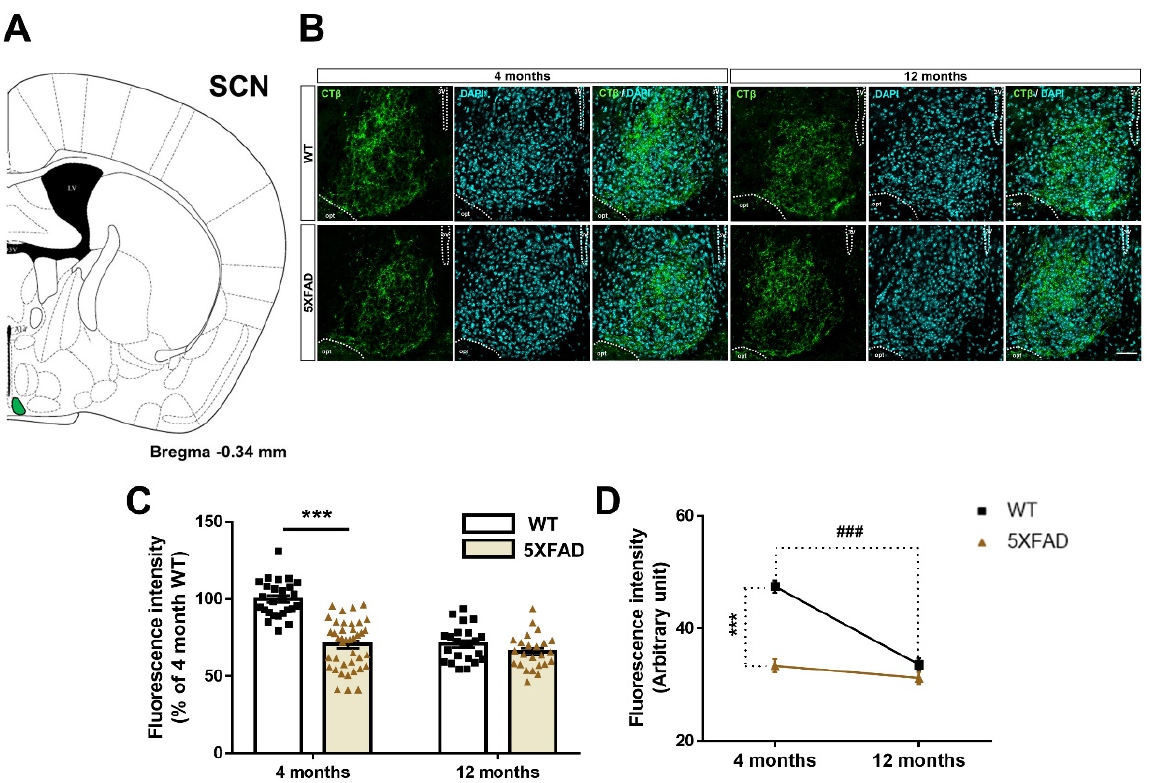
Figure 3. Impairment of the retina-suprachiasmatic nucleus (SCN) pathway in WT and 5XFAD mice. ( A ) Diagram of a mouse brain section explaining the location of the SCN. ( B ) The representative image shows CT β -labeled terminal buttons of the axon in the SCN of 4- and 12-month-old WT and 5XFAD mice. Scale bar = 50 µ m. ( C ) The quantitative graph exhibits the fluorescence intensity of the CT β (+) area in the SCN of WT and 5XFAD mice (24–40 images of the brain sections were obtained from 5 mice in each group). ( D ) Comparison of the impairment of the retina-SCN pathway by aging and AD progression. Statistical analysis was conducted by two-way ANOVA, followed by Tukey’s post hoc test. *** p < 0.001 and ### p < 0.001 indicate a significant